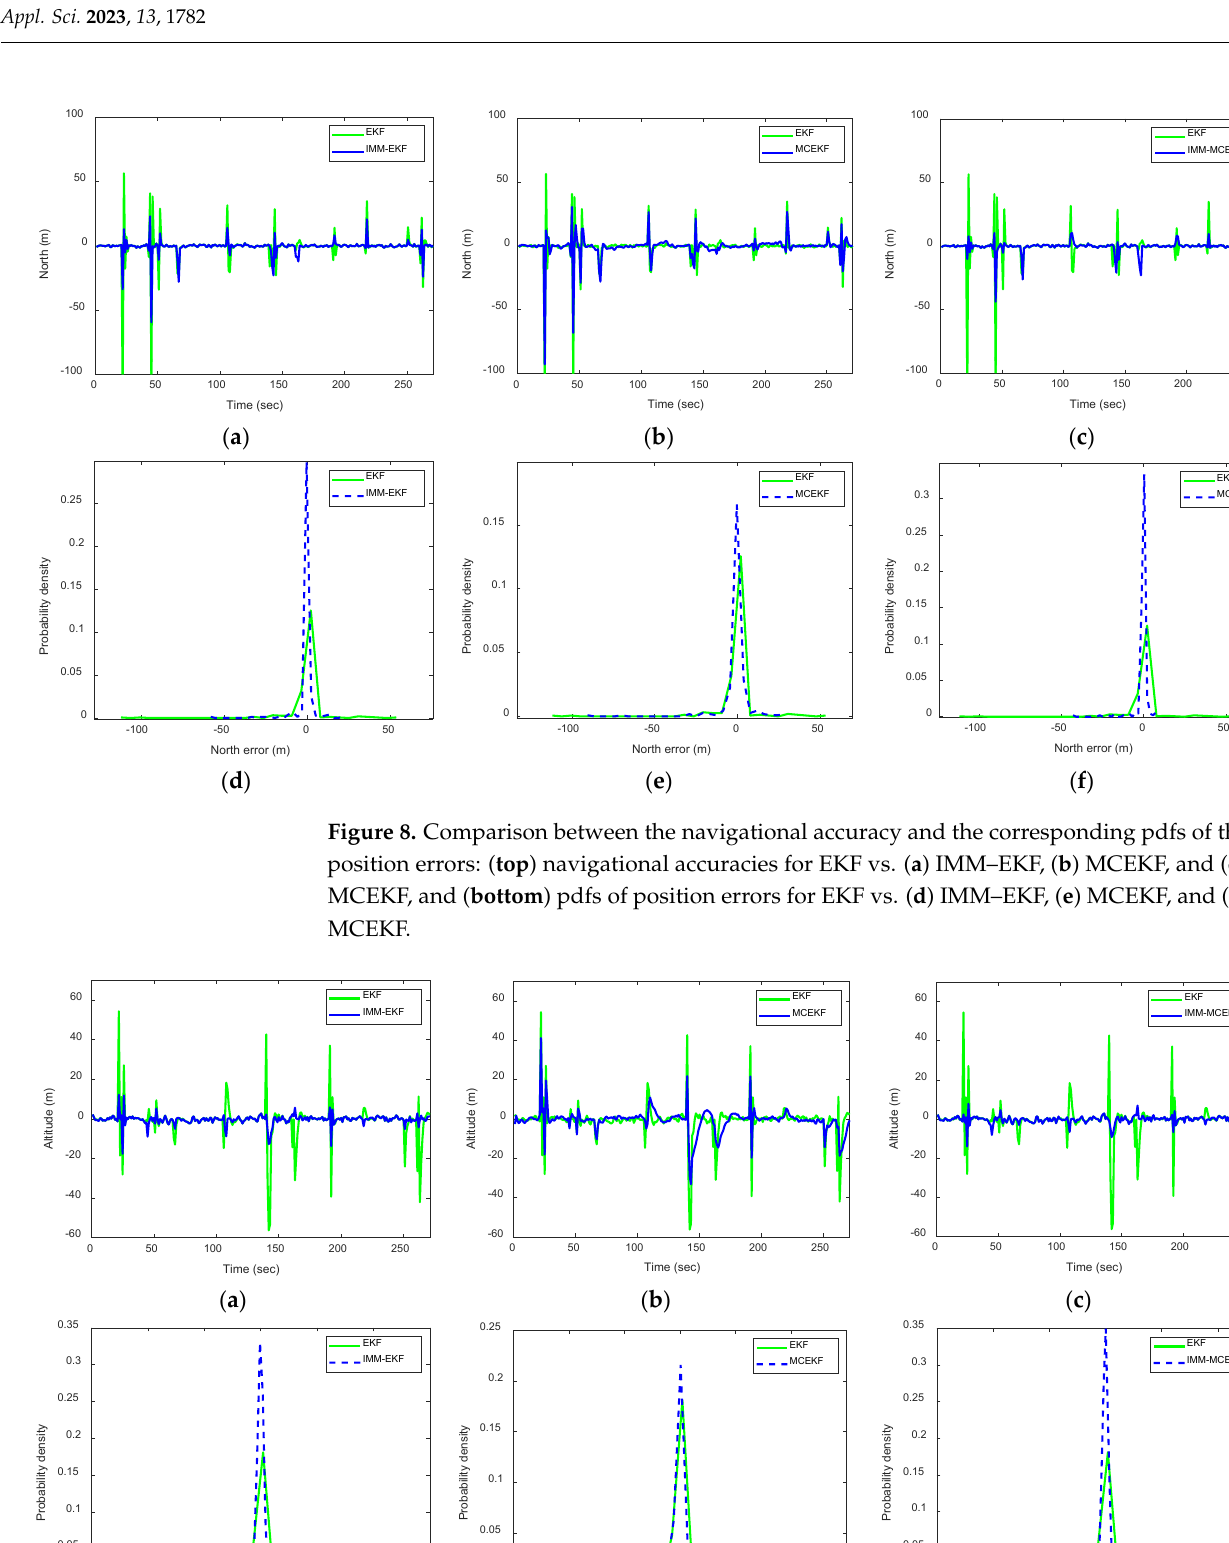
Figure 7. Comparison between the navigational accuracy and the corresponding probability den- sity functions (pdfs) of the east position errors: ( top ) navigational accuracies for EKF vs. ( a ) IMM– EKF, ( b ) MCEKF, and ( c ) IMM–MCEKF, and ( bottom ) pdfs of position errors for EKF vs. ( d ) IMM– EKF, ( e ) MCEKF, and ( f ) IMM–MCEKF.